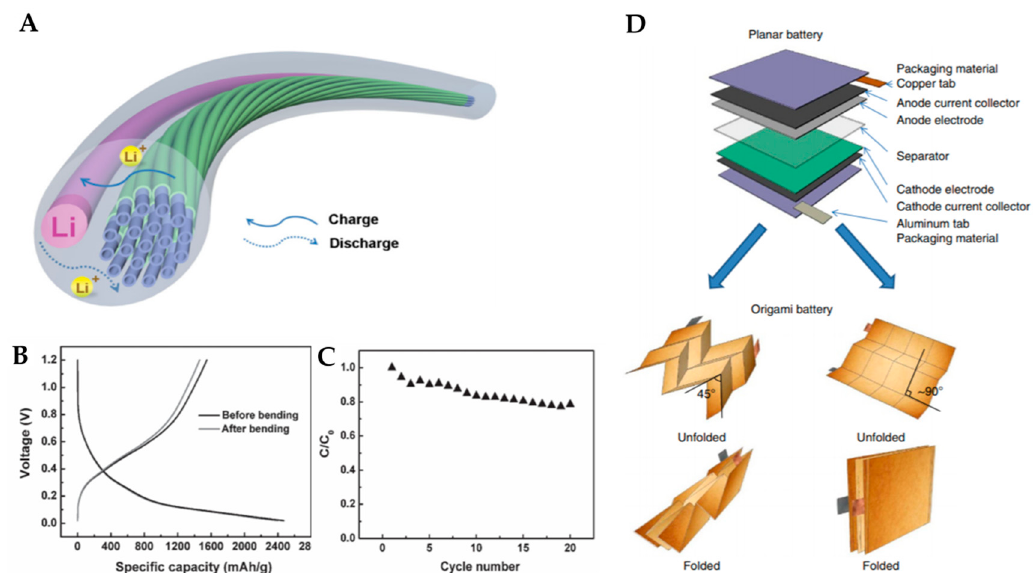
Figure 4. ( A ) Schematic illustration of a lithium-ion battery based on the aligned MWCNT / Si composite fiber as a working electrode. Adapted with permission from [53]. Copyright (2013) WILEY-VCH Verlag GmbH and Co. KGaA, Weinheim. ( B ) Charge and discharge curves of a half-cell based on the aligned MWCNT / Si composite fiber with a Si weight percentage of 38.1% before and after bending for 100 cycles at 2 Ag − 1 . ( C ) Dependence of specific capacity on cycle number for the composite fiber after bending for 100 cycles at 2 Ag − 1 . Adapted with permission from [53]. Copyright (2013) WILEY-VCH Verlag GmbH and Co. KGaA, Weinheim. ( D ) Schematic illustration of origami lithium-ion battery (LIB). It shows two features of LIBs: (1) Exploded view of the multilayer structure of conventional LIBs in the planar state and (2) two examples of origami LIBs using Miura folding. Adapted with permission from [54]. Copyright (2014) Macmillan Publishers Limited.